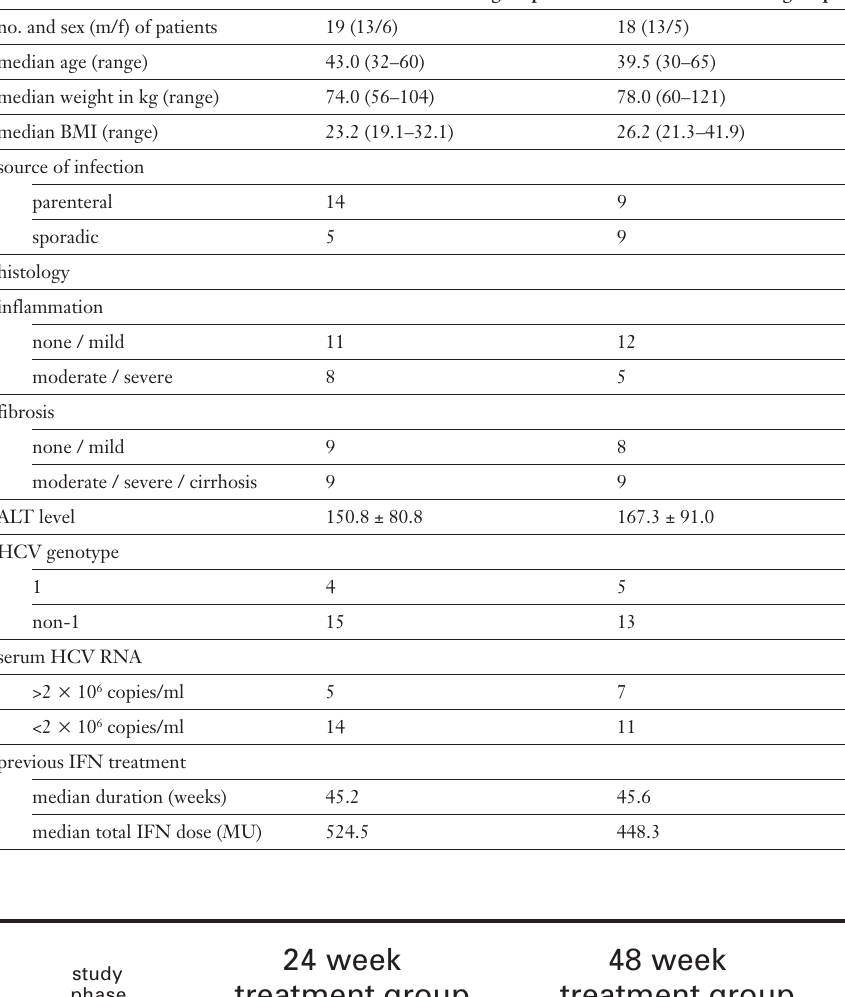
Comparison of base- line characteristics.